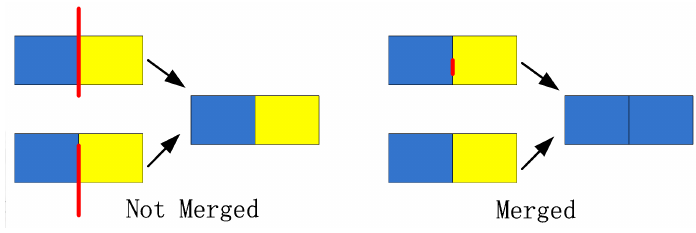
Figure 7. Conditions of building area